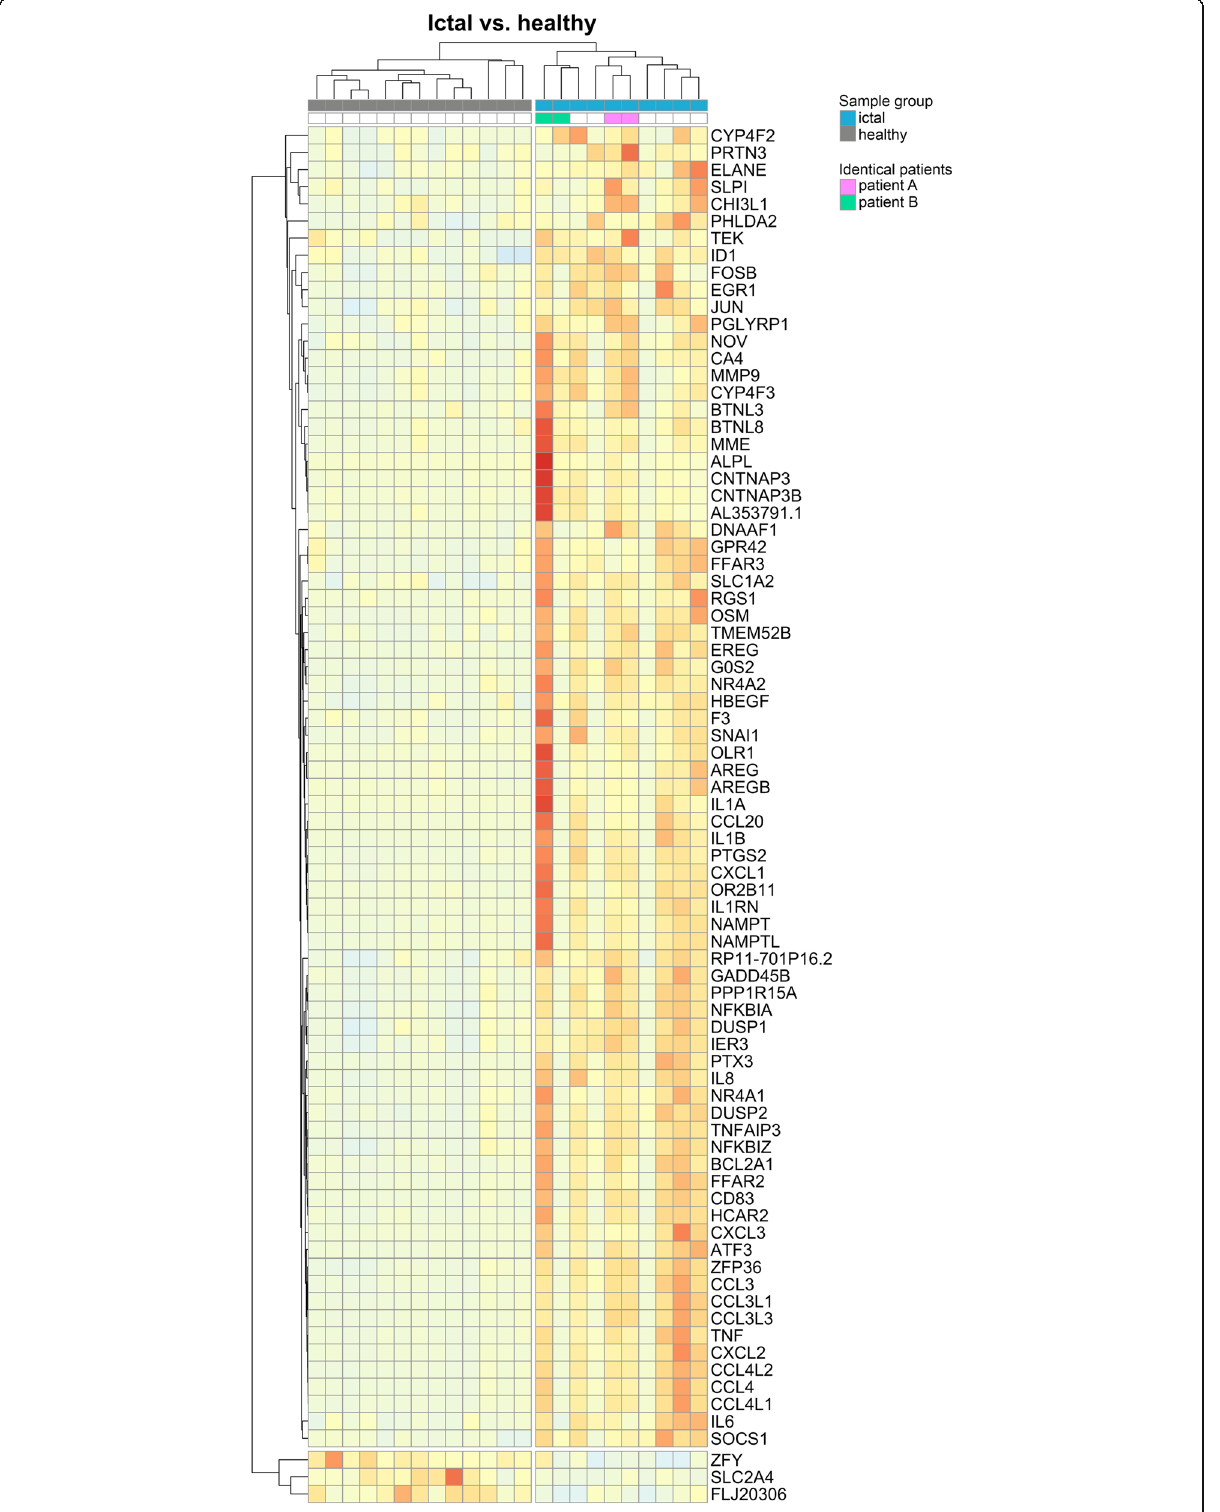
Fig. 3 Heat map representation of differentially expressed genes in the ictal vs. healthy comparison. Columns represent samples, rows represent genes. Pearson correlation was respectively calculated between samples and genes, visualized by dendrograms. Ictal samples from identical patients ( “ A ” , “ B ” ) are marked with respective colors in the